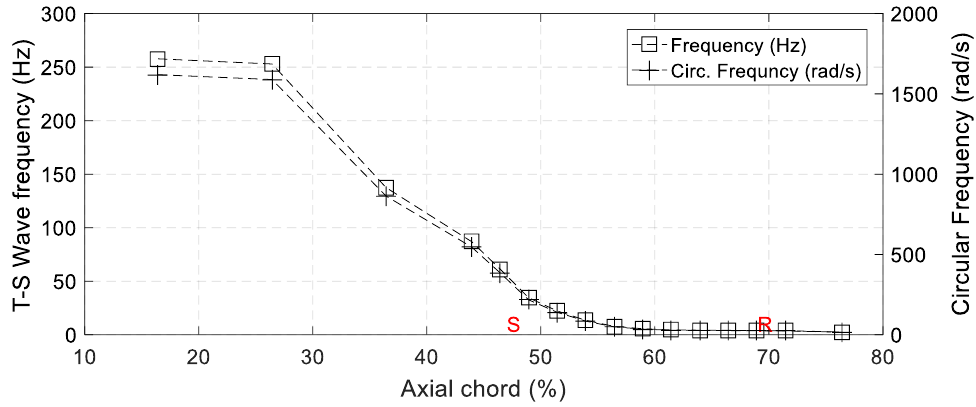
Figure 7. Power spectra calculated from hotwire velocity signals for ( a ) steady-inlet and ( b ) wake-inlet.